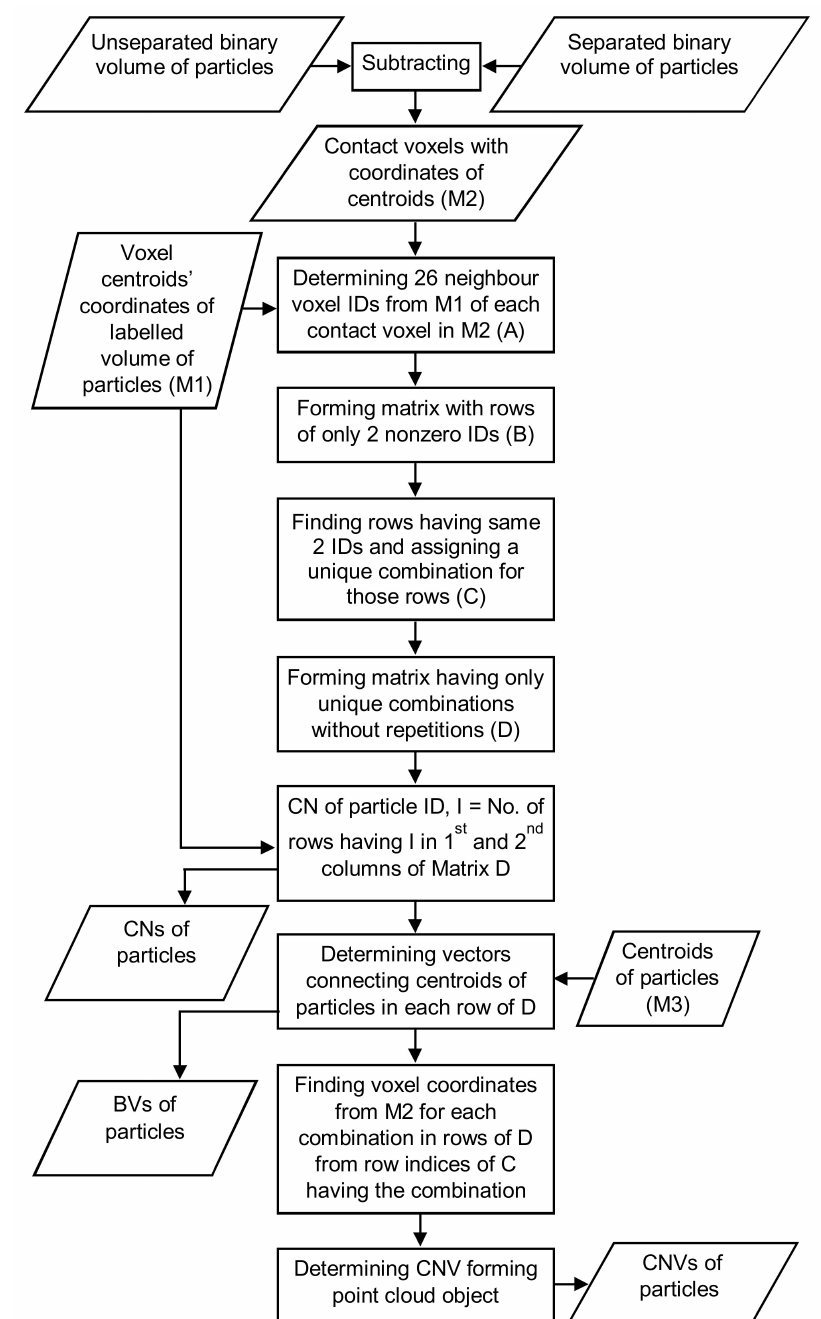
Figure 5. Algorithm flowchart of the code for determining coordination number (CN), branch vector (BV) and contact normal vector